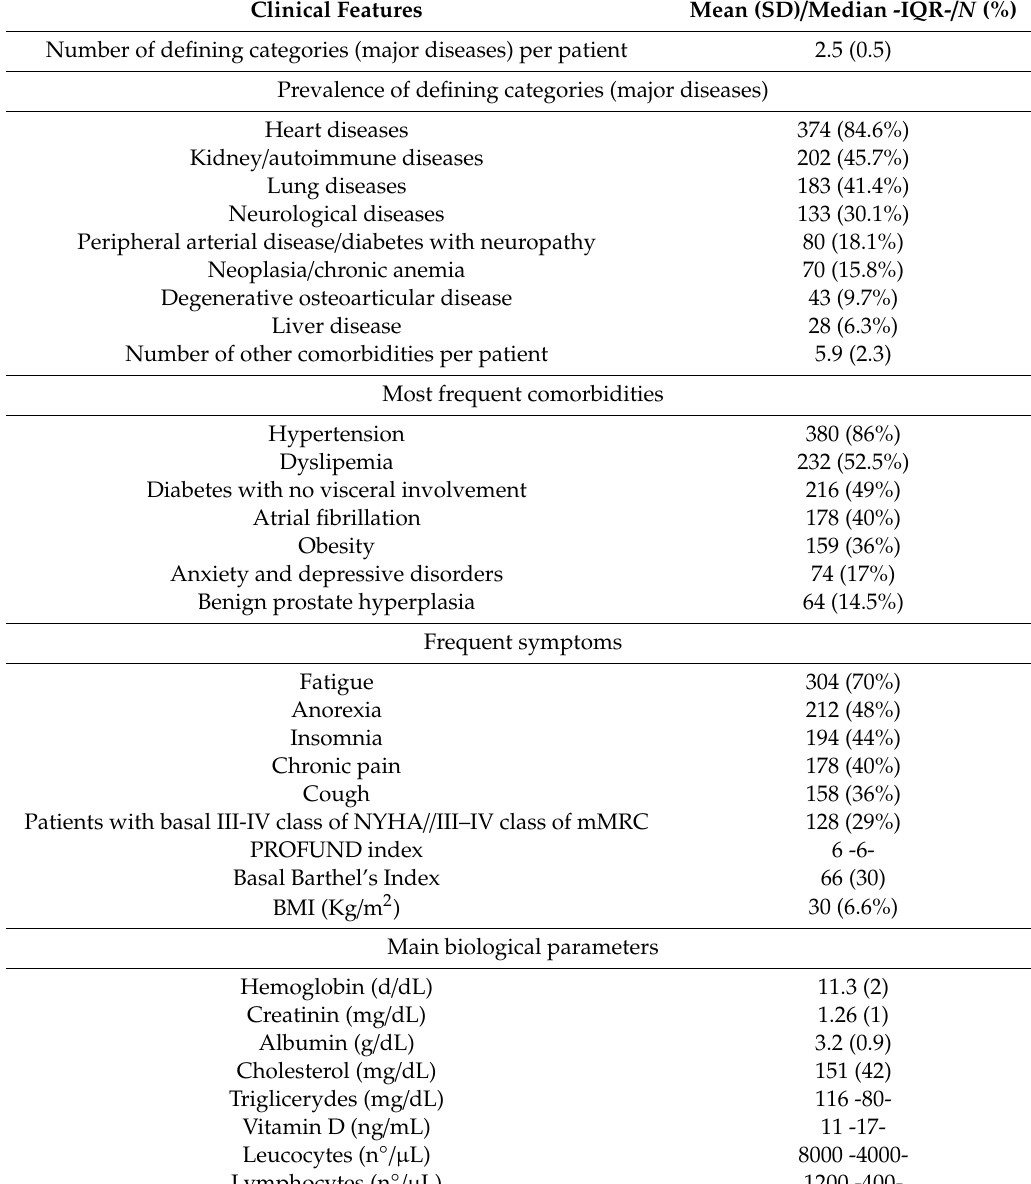
Table 1. Main clinical and biological features of a multicenter sample of 444 polypathological patients recruited for sarcopenia and frailty